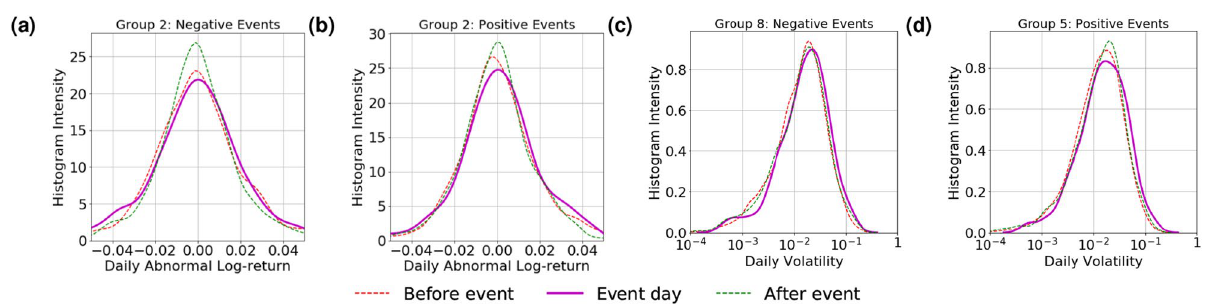
Figure 5. Probability density function of AR and daily realised volatility of Group 2 companies, computed over all group-aggregated sentiment events over the time period: ( a ) AR around negative events , ( b ) AR around positive events , ( c ) Volatility around negative events , ( d ) Volatility around positive events